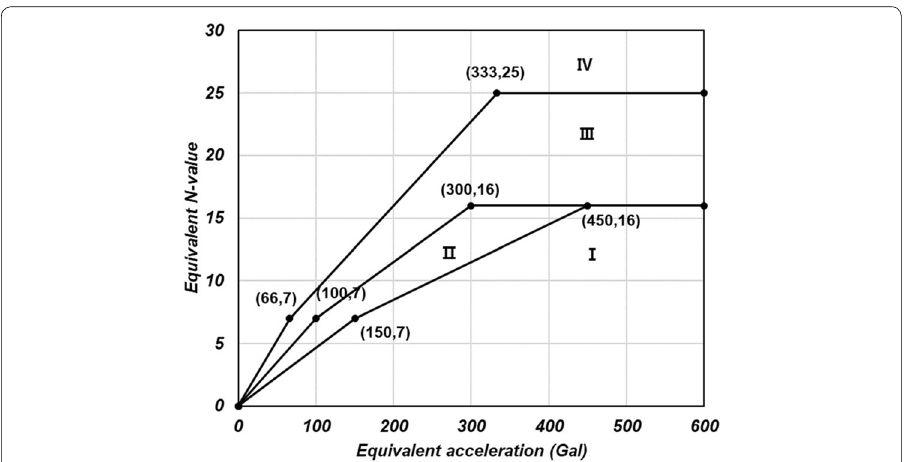
Fig. 10 Classification of Soil Layer by Equivalent N‑Value and Equivalent Acceleration [9]